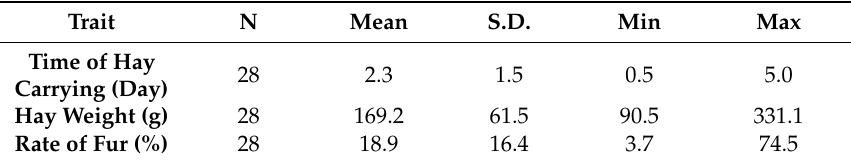
Table 3. Descriptive statistics of the traits measured in the experiment.